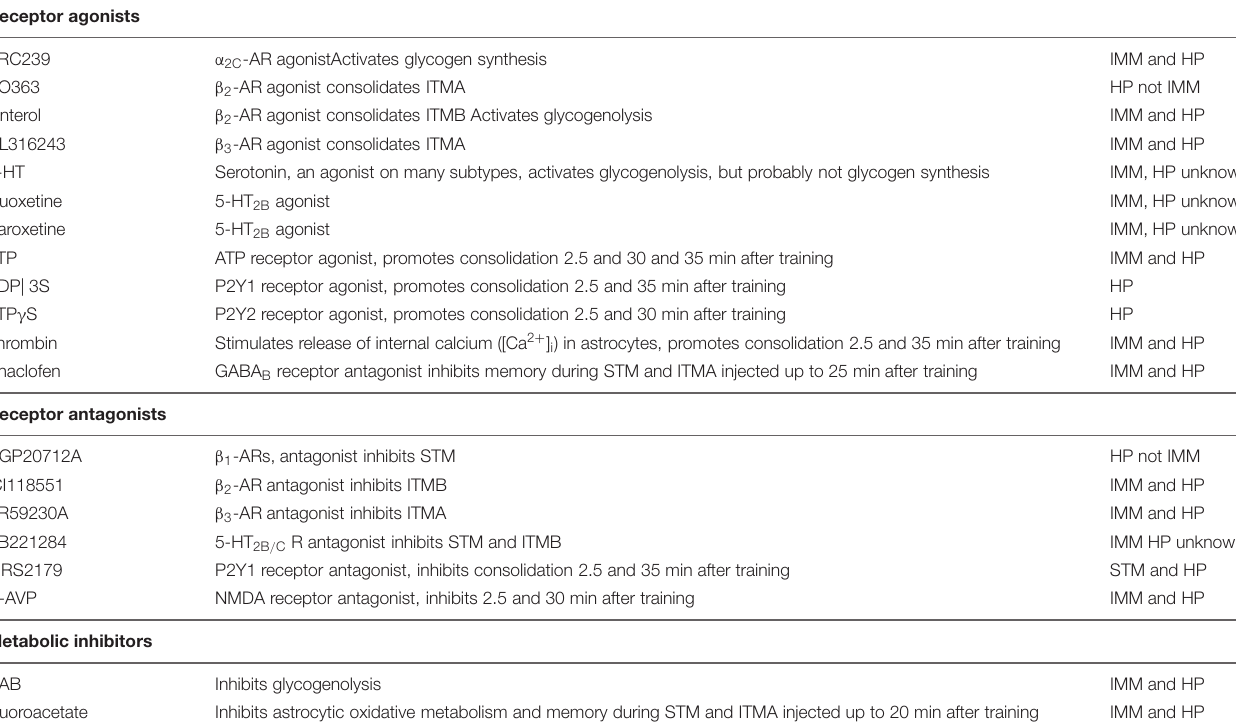
TABLE 1 | Individual effects of drugs on glycogenolysis and memory in imm and hippocampus (Hp). Receptor agonists